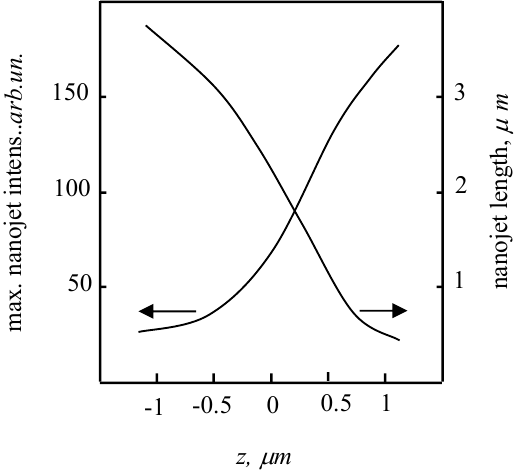
Figure 4 ： Maximal intensity in the vicinity of nanojet and nanojet length (in the absence of particle) versus positions of the inner sphere B